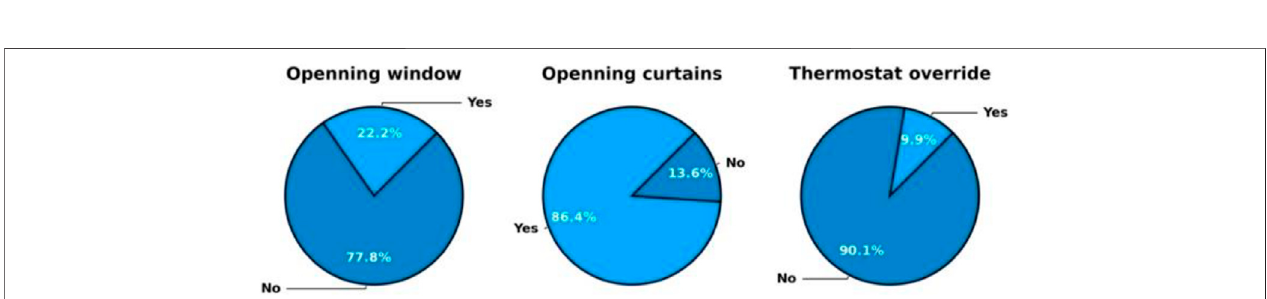
FIGURE 10 | Human interaction with of fi ce lighting and equipment during break times and after leaving of fi ce.